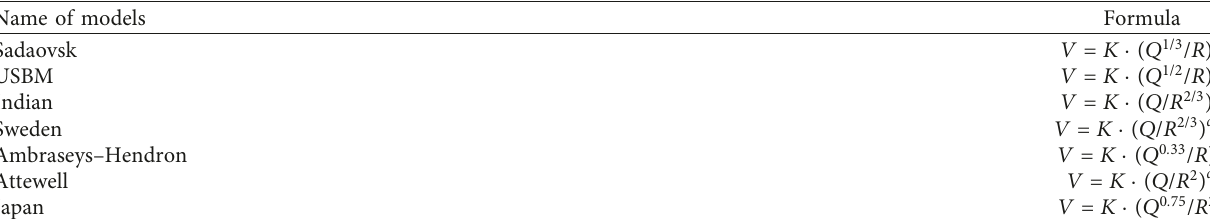
Table 3: Different prediction